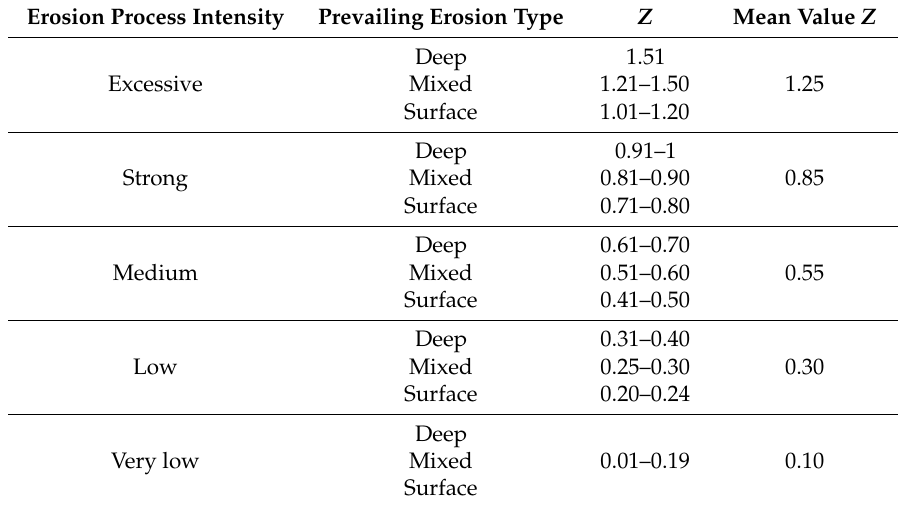
Table 1. Categorization and range of Erosion Potential Method (EPM) coe ffi cients Z